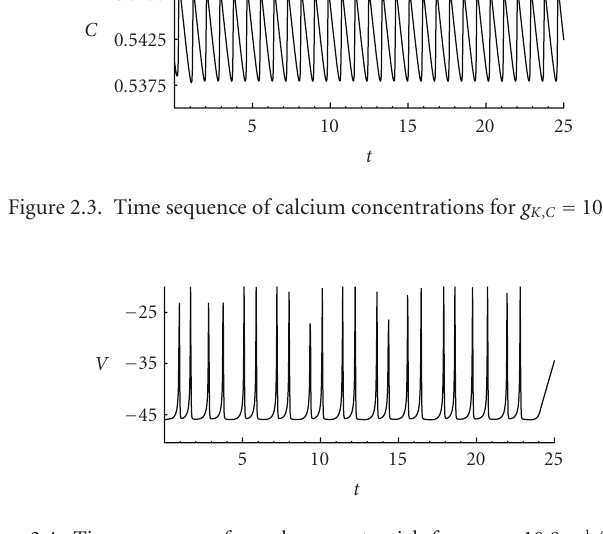
Figure 2.4. Time sequence of membrane potentials for g K , C = 10 . 8 s − 1